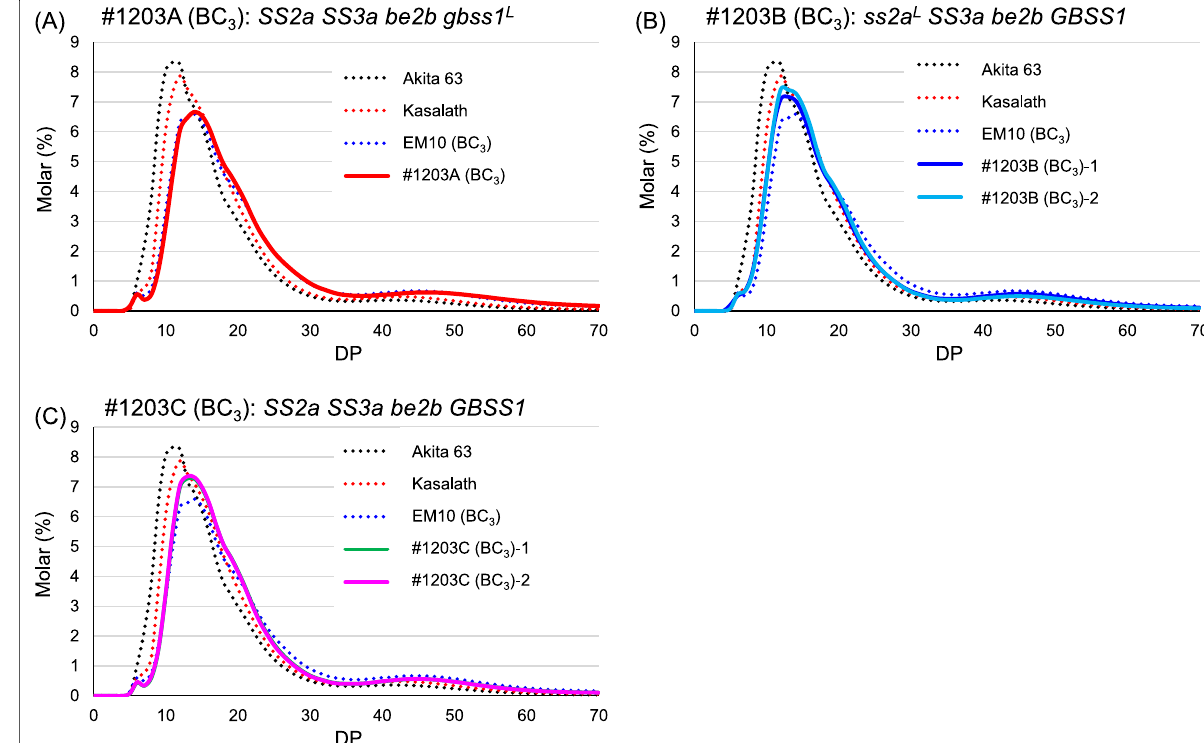
(BC 3 )—EM10 BC 3 ” and “#1203C (BC 3 )—#1203B (BC 3 )”